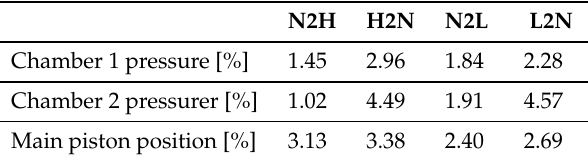
Table 1. Euclidean norms of the error signals.